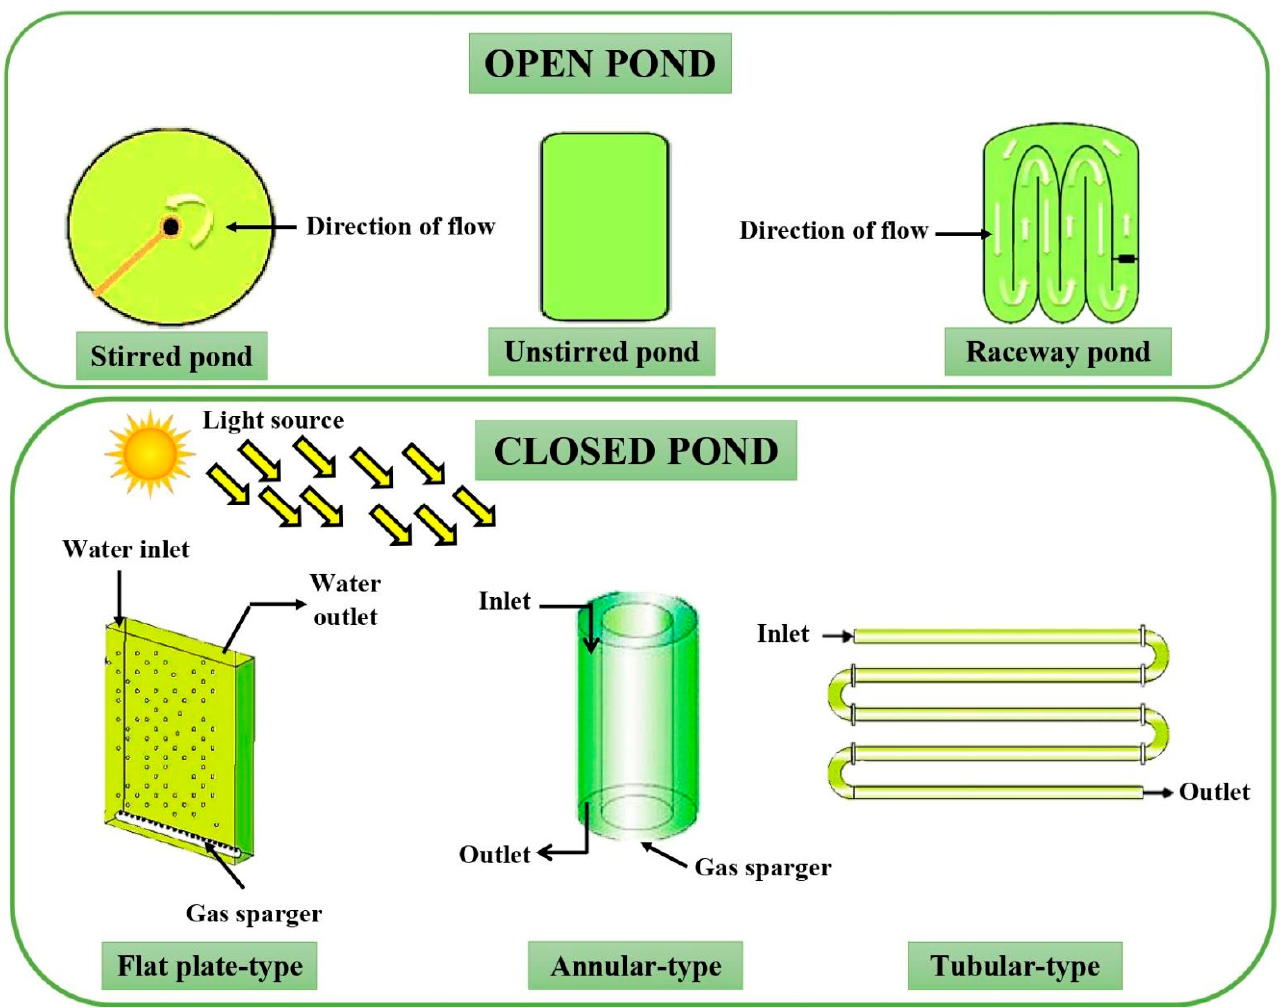
Figure 3. Open and closed pond cultivation system of microalgae.